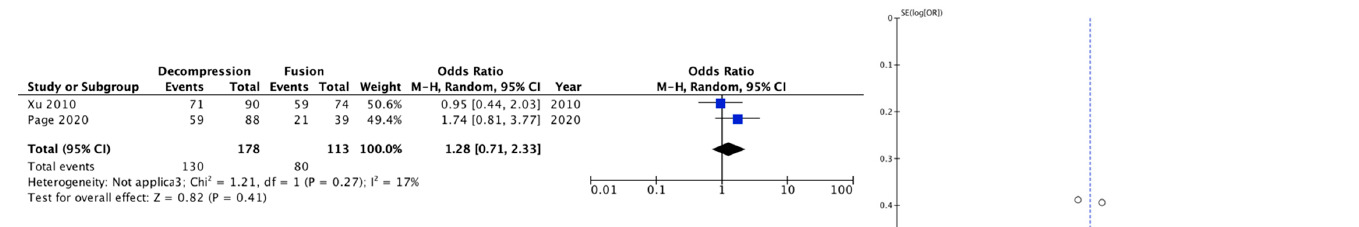
Figure A1. Sex (male).